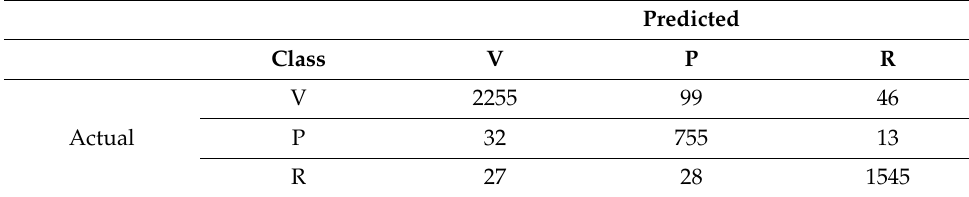
Table 3. Example of confusion